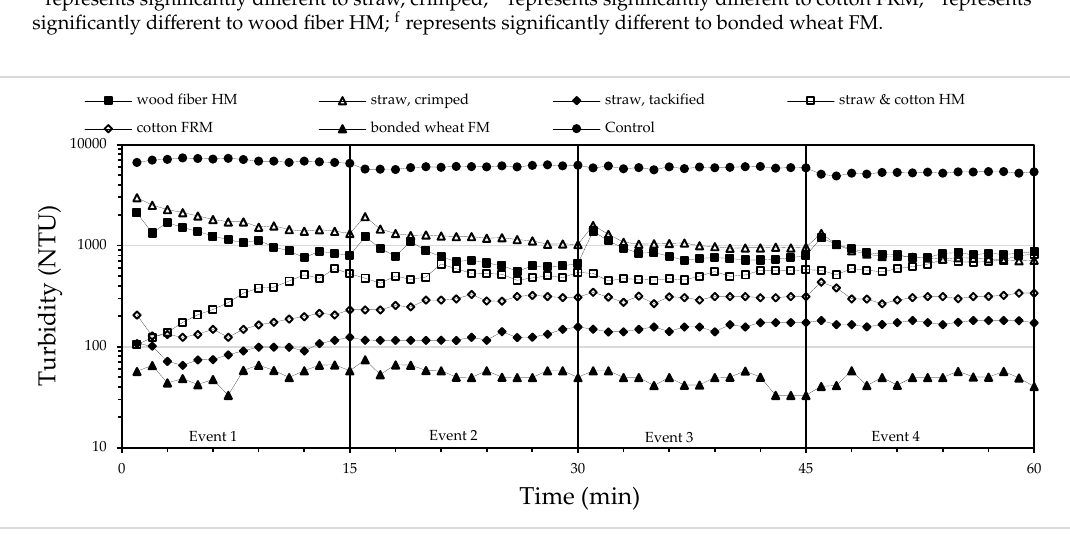
Table 4. Average turbidity, standard deviation, and percent reduction of each treatment with respect to the control of four 15-min events for surface runoff. Treatment